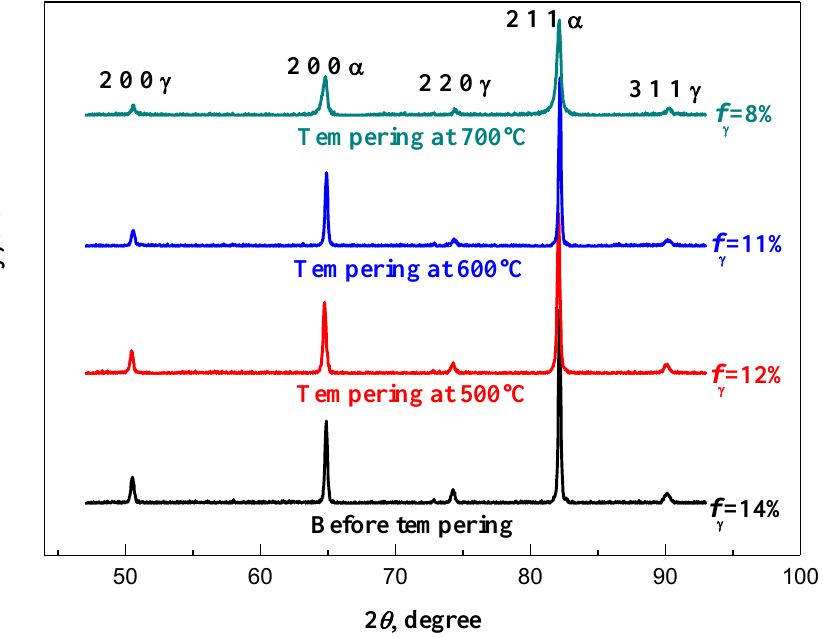
Figure 5. XRD spectra for samples before and after tempering at 500 – 700 °C.